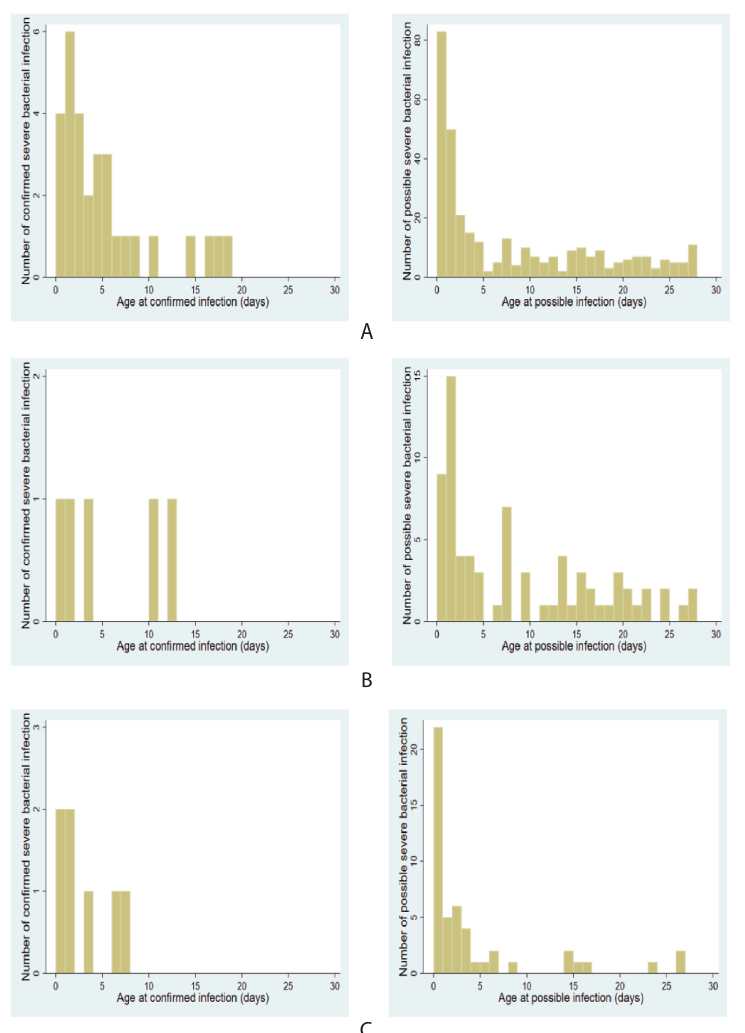
Fig 4. Timing of cSBI and pSBI among neonates. (A) Madagascar, (B) Cambodia, and (C) Senegal. cSBI, confirmed severe bacterial infection; pSBI, possible severe bacterial infection.